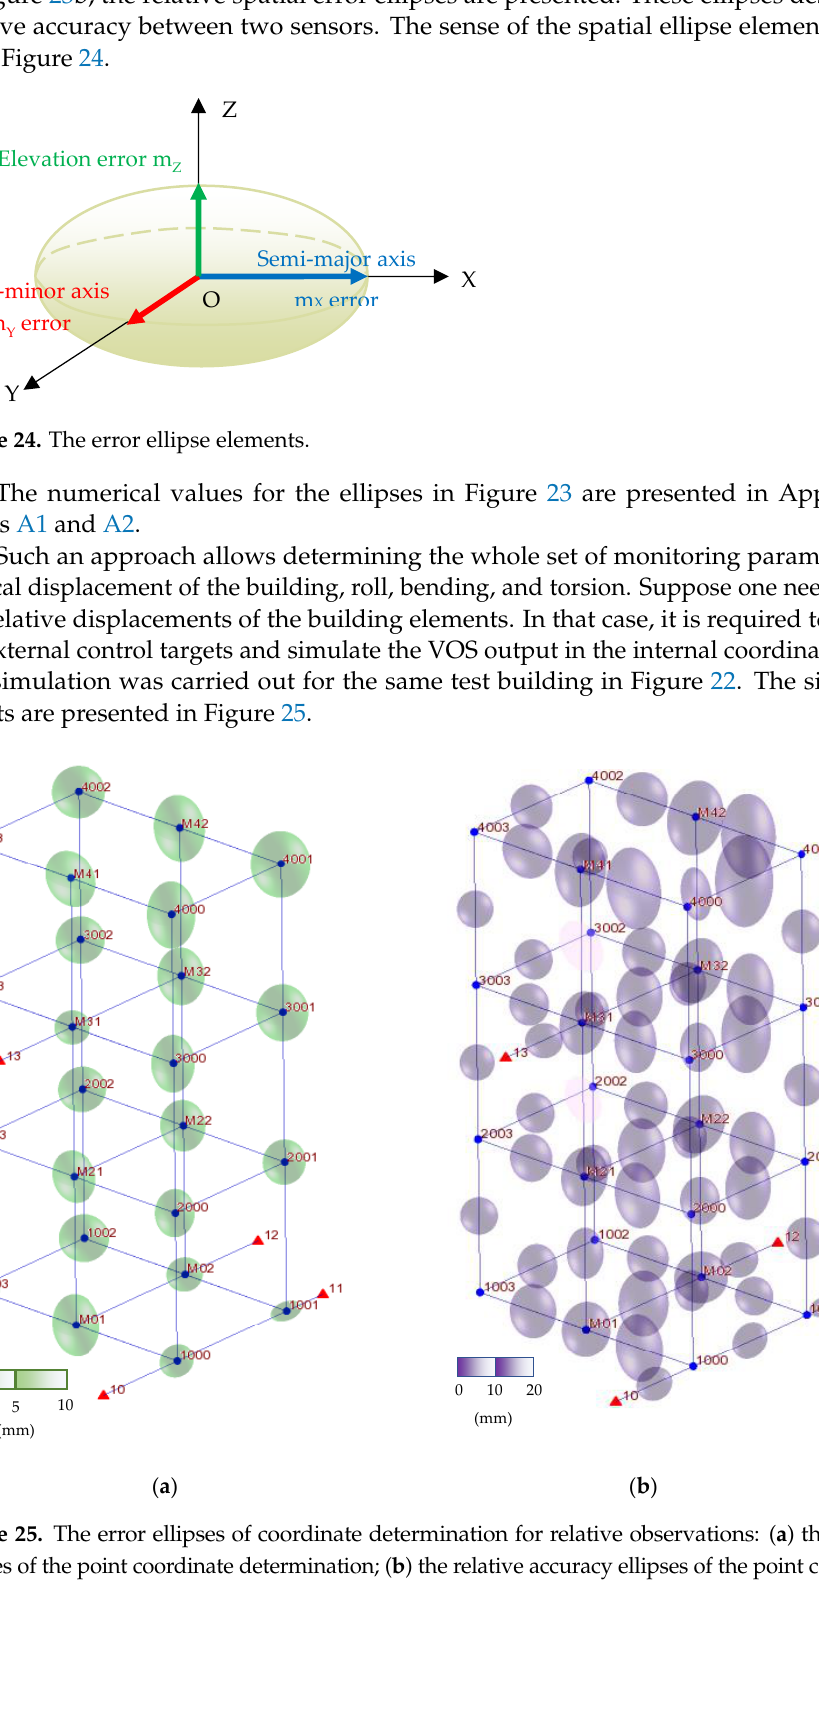
Figure 23. The error ellipses of coordinate determination: ( a ) the accuracy ellipses of the point coor- dinate determination; ( b ) the relative accuracy ellipses of the point coordinates.